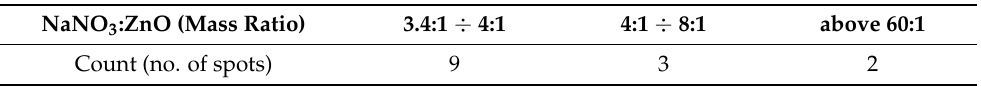
Table 1. Analysis of microparticle composition stability by NaNO 3 –ZnO mass ratio after multiple phase-change thermal cycles.